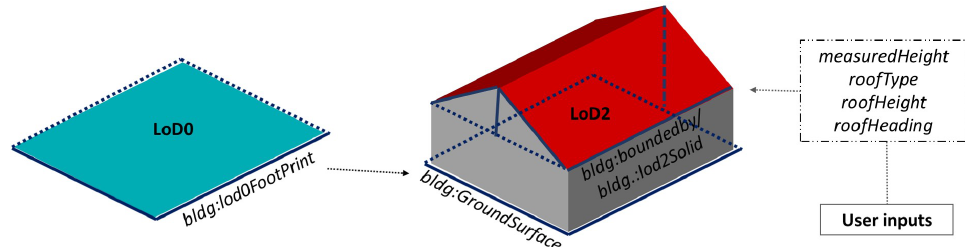
Figure 10. An overview of the transformed LoD0 to LoD2 model (B2) of FZK House along with the user inputs considered for the